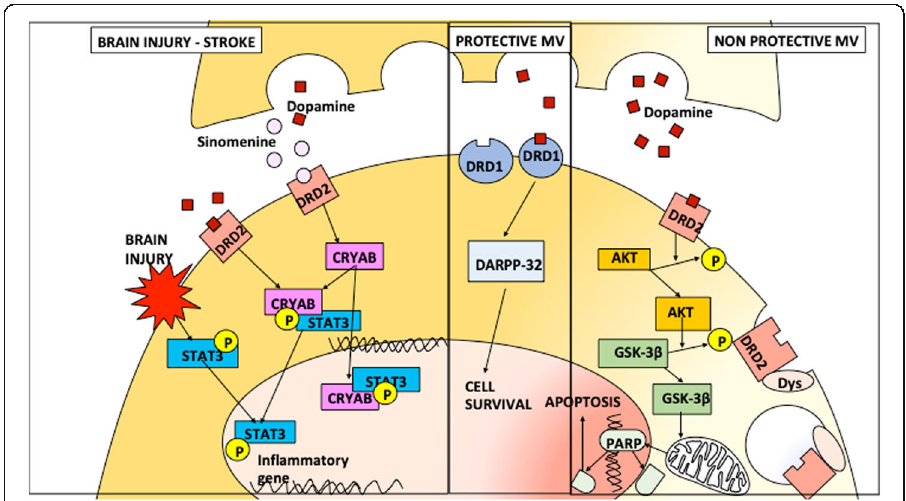
Fig. 2 Mechanisms of immunomodulation and cell apoptosis induced by the dopamine pathway. Under normal conditions, dopamine activates type 1 receptors (DRD1), promoting cell survival. The increased release of dopamine triggered by non-protective mechanical ventilation activates type 2 receptors (DRD2), triggering a cascade of events resulting in apoptosis. Activation of astrocytic DRD2 induces upregulation and nuclear translocation of the α B-crystallin CRYAB/STAT3 pathway, which alleviates neuroinflammatory injury by reducing the generation of pro-inflammatory cytokines. In this context, dopamine agonists and antagonists can play a role in regulating the neuroinflammatory response; in particular, haloperidol — which competitively blocks postsynaptic dopamine receptors in the mesolimbic dopaminergic system — has different effects on cell survival depending on the use of protective and non-protective ventilation. Sinomenine can blunt the CRYAB/STAT3 pathway by acting on DRD2 receptors,